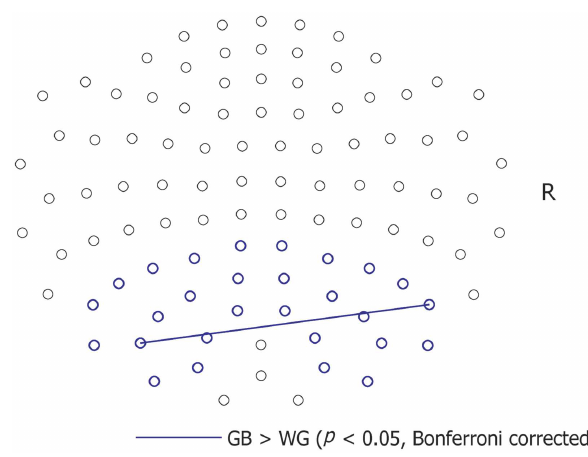
FIGURE 3 | Sensor-based coherence .The blue lines indicate significantly greater coherence between sensors under the GB than under theWG condition. Significantly greater coherence ( p < 0.05, with Bonferroni correction) under theWG than under the GB condition was not